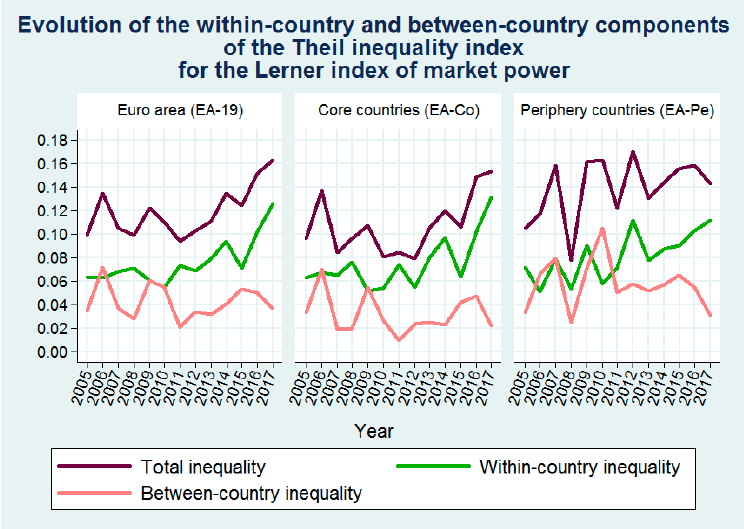
Figure 7. Evolution of the within-country and between-country components of the Theil inequality index for the Lerner index of market power. Source: BankScope database, own calculations.